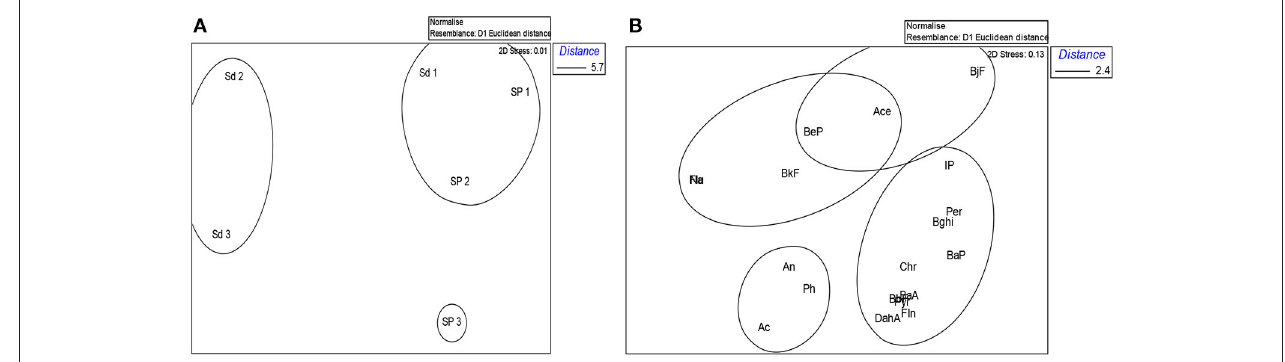
FIGURE 2 | Non-Metric Multidimensional Scaling analysis (NMDS) plots. (A) Ordination of sampled sites in the Rufiji estuary. (B) Non-Metric Multidimensional Scaling analysis (NMDS) plots. Ordination of PAH groupings along the sampled sites. Stress factor = 0.13. Na, naphthalene; Ac, acenaphthylene; Ace, acenaphthene; Flu, fluorine; An, anthracene; Ph, phenanthrene; Fln, fluoranthene; Pyr, pyrene; BaA, benzo[a]anthracene; Chr, chrysene; BaP, benzo[a]pyrene; BeP, benzo[e]pyrene; BbF, benzo[b]fluoranthene; BjF, benzo[j]fluoranthene; BkF, benzo[k]fluoranthene; Bghi, benzo[hgi]perylene; IP, Indeno[1,2,3-cd]pyrene; Per, perylene; DahA, dibenzo[a,h]anthracene. Stress factor =